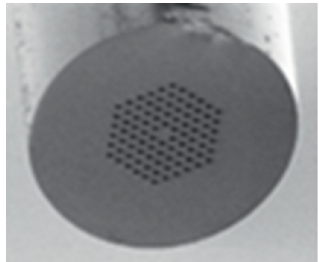
Figure 27. SEM image of PCF used for long-period gratings inscription and structural health monitoring (Reproduced from [89], with the permission of Elsevier publishing).